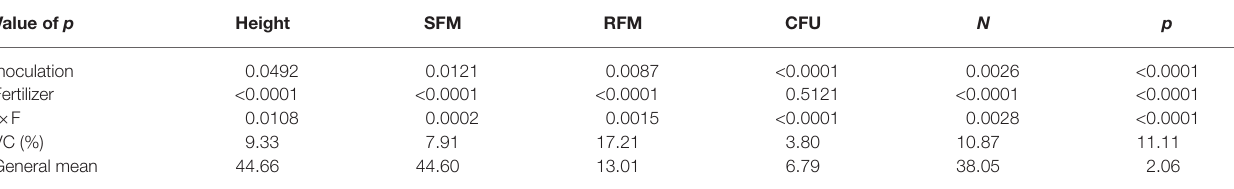
TABLE 1 | Height, shoot fresh matter (SFM), root fresh matter (RFM), CFU of endophytic Bacillus subtilis recovered from soybean roots, nitrogen and phosphorus concentrations in soybean plant shoots as a function of fertilization dose. Value of p